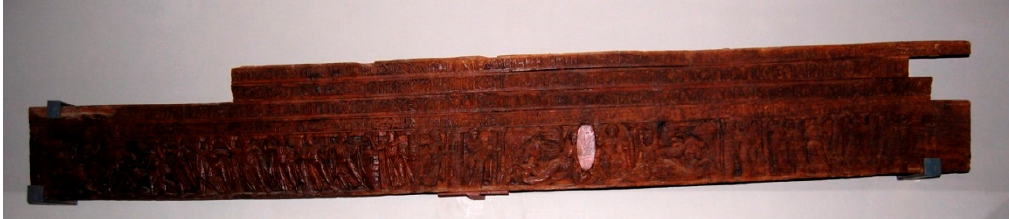
Figure 21. Lintel from El-Moallaka (8th century). © Cairo, Coptic Museum (with kind permission).